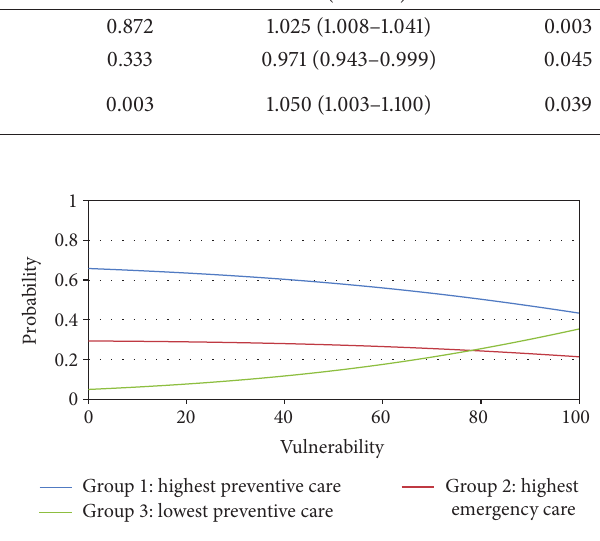
Figure 1: Probability of pertaining to each cluster according to vulnerability in Belo Horizonte, Brazil, 2010.